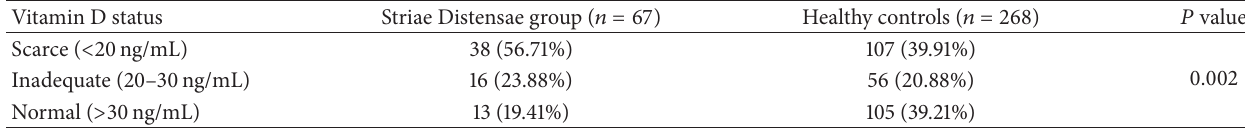
Table 2: Confrontation of serum 25OHD status in Striae Distensae and non-Striae Distensae